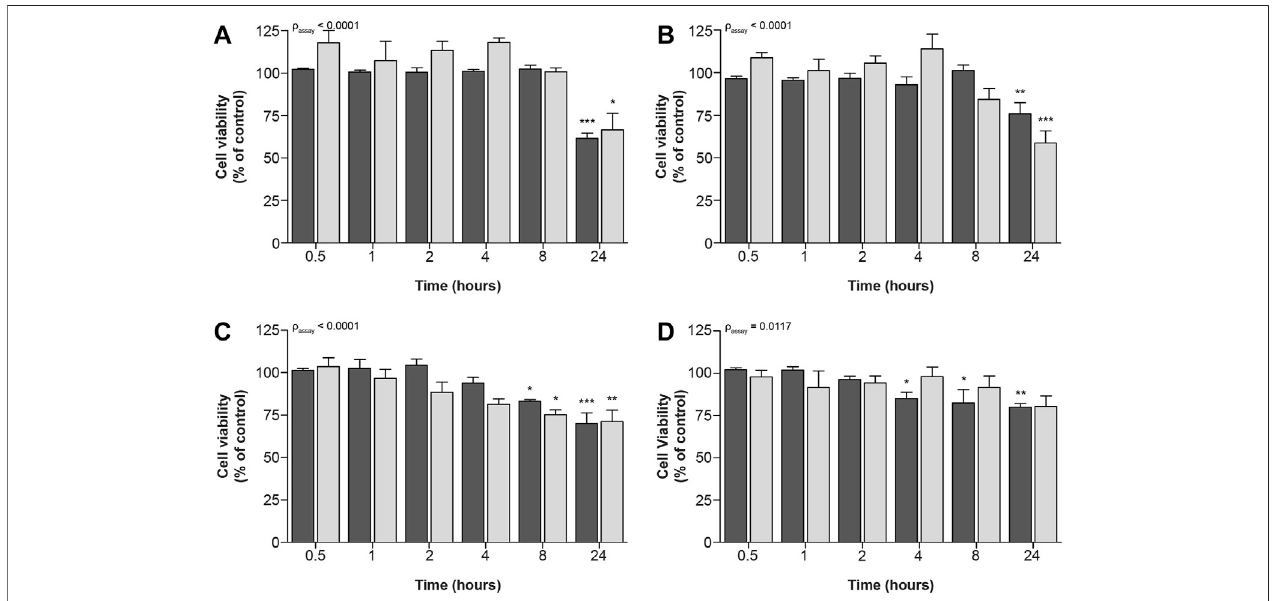
FIGURE 4 | Time-dependent effects upon exposure of ciPTEC-OAT1 to IC 70 -concentrations of nephrotoxic drugs on cellular metabolic activity and fl uorescence-based cell death. Mature ciPTEC-OAT1 were exposed to IC 70 concentrations of nephrotoxic drugs for 0.5, 1, 2, 4, 8 and 24 h, after which fl uorescence-based cell death or ( ■ ) cellular metabolic activity ( ■ ) assays were performed. (A) cisplatin, (B) tenofovir, (C) sanguinarine, (D) chloroacetaldehyde. For IC 70 -values see Table 1 . All results were normalized to unexposed controls. Statistical analyses: one-way ANOVA corrected for multiple comparison by Dunnett ’ s post hoc analysis to compare differences between vehicle control and exposed conditions * p < 0.05, ** p < 0.01, *** p < 0.001; and two-way ANOVA corrected for multiple comparison by Bonferroni ’ s post hoc analysis to compare differences between assays. p -value corresponding to overall signi fi cance between assays is indicated for each compound. Mean ± SEM; n = 3 independent experiments.